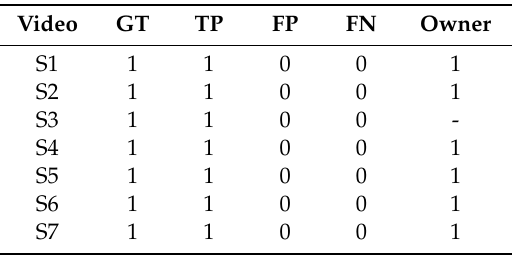
Table 1. Test results for PETS2006 Table 1 . Test results for PETS2006 dataset.